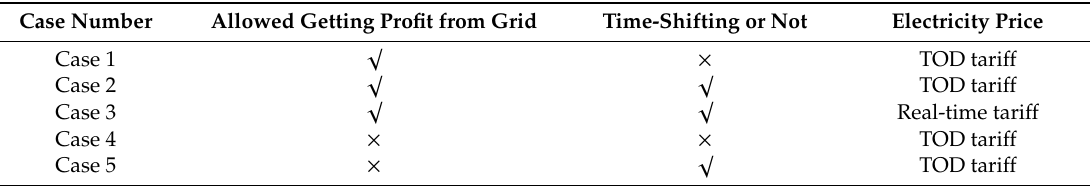
Table 13. The specific setup for each